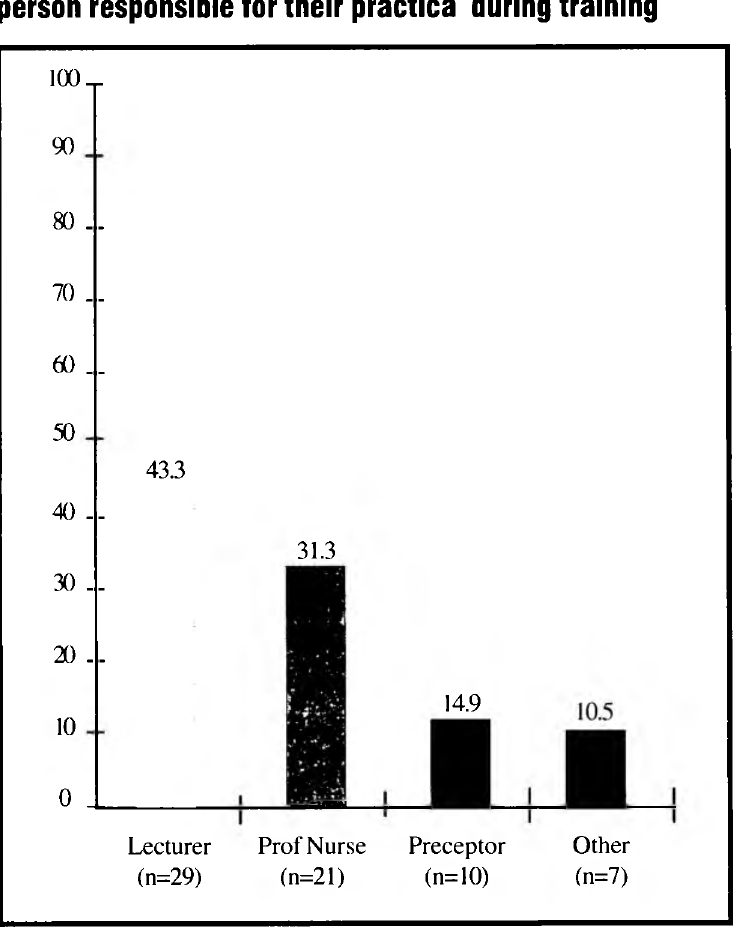
Open-ended questions were categorised, similarities in each category identified and clustered. Themes were formulated, coded, and similar codes enumerated to quantify